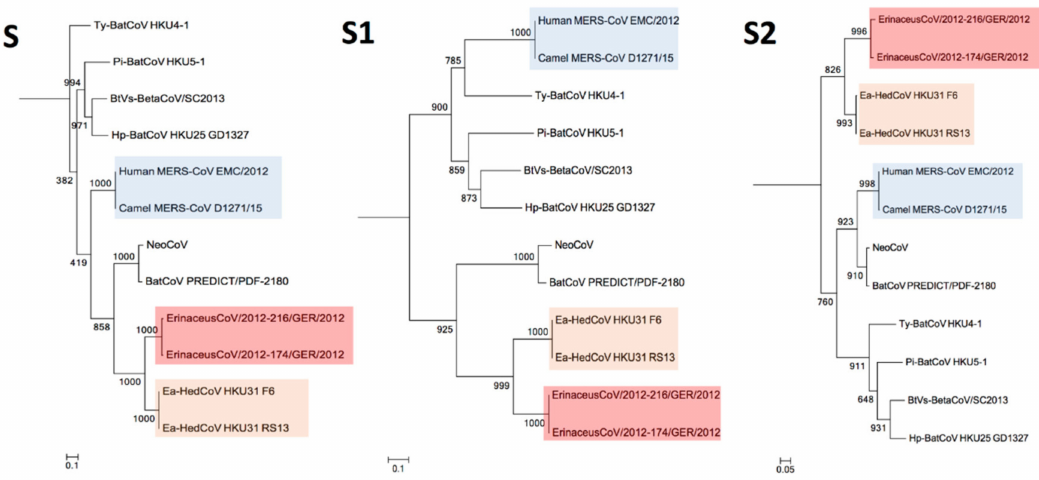
Figure 6. Phylogenetic analyses of S, S1 and S2 amino acid sequences of Ea -HedCoV HKU31 and other members of Merbecovirus . The maximum likelihood method was used to construct S and S1 tree by using WAG + G + F substitution models. The maximum likelihood method was used to construct S2 tree by using LG + G + F substitution model. Bootstrap values were calculated from 1000 trees. Corresponding sequences of HCoV HKU1 were included for trees rooting (GenBank accession number NC_006577). All bootstrap values are shown. The scale bars represent 10, 10 and 20 substitutions per site in S, S1 and S2 trees respectively. Human and camel MERS-CoVs are highlighted in blue. The two Erinaceus betacoronaviruses from Europe are highlighted in red. The two Ea -HedCoV HKU31 strains, F6 and RS13, detected in this study are highlighted in